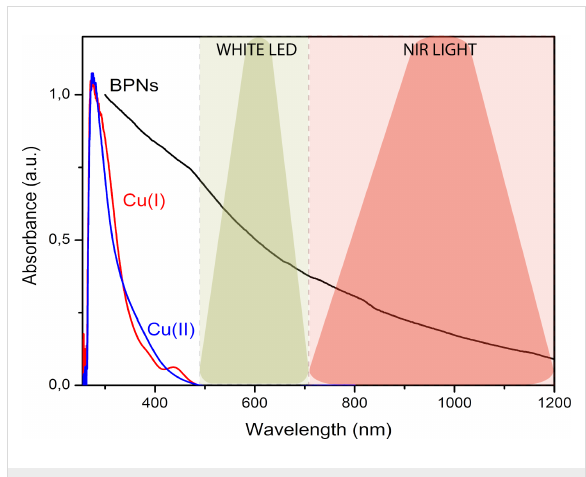
Figure 2: UV–vis spectra of Cu I Cl, Cu II Cl 2 and BPNs.